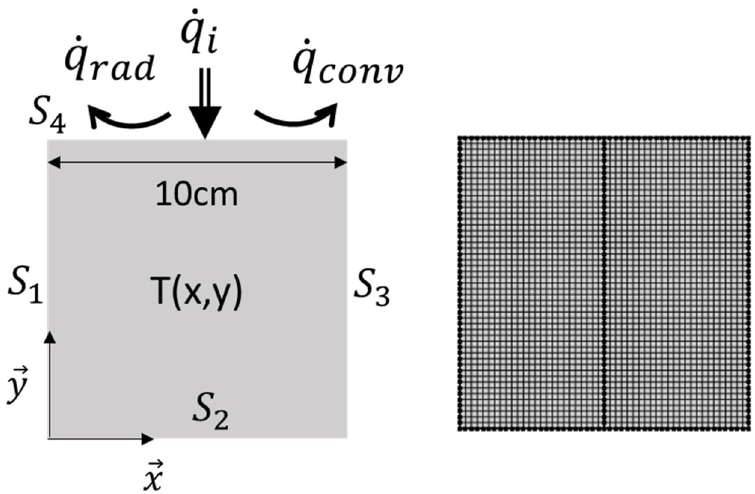
Figure 1. Finite element simulation: initial sample geometry, boundary conditions and mesh ( q(cid:4662) (cid:2919) , q(cid:4662) (cid:2928)(cid:2911)(cid:2914) and q(cid:4662) (cid:2913)(cid:2925)(cid:2924)(cid:2932) correspond to the incident heat flux, the heat flux due to re-radiation and the heat flux due to convection losses, respectively).